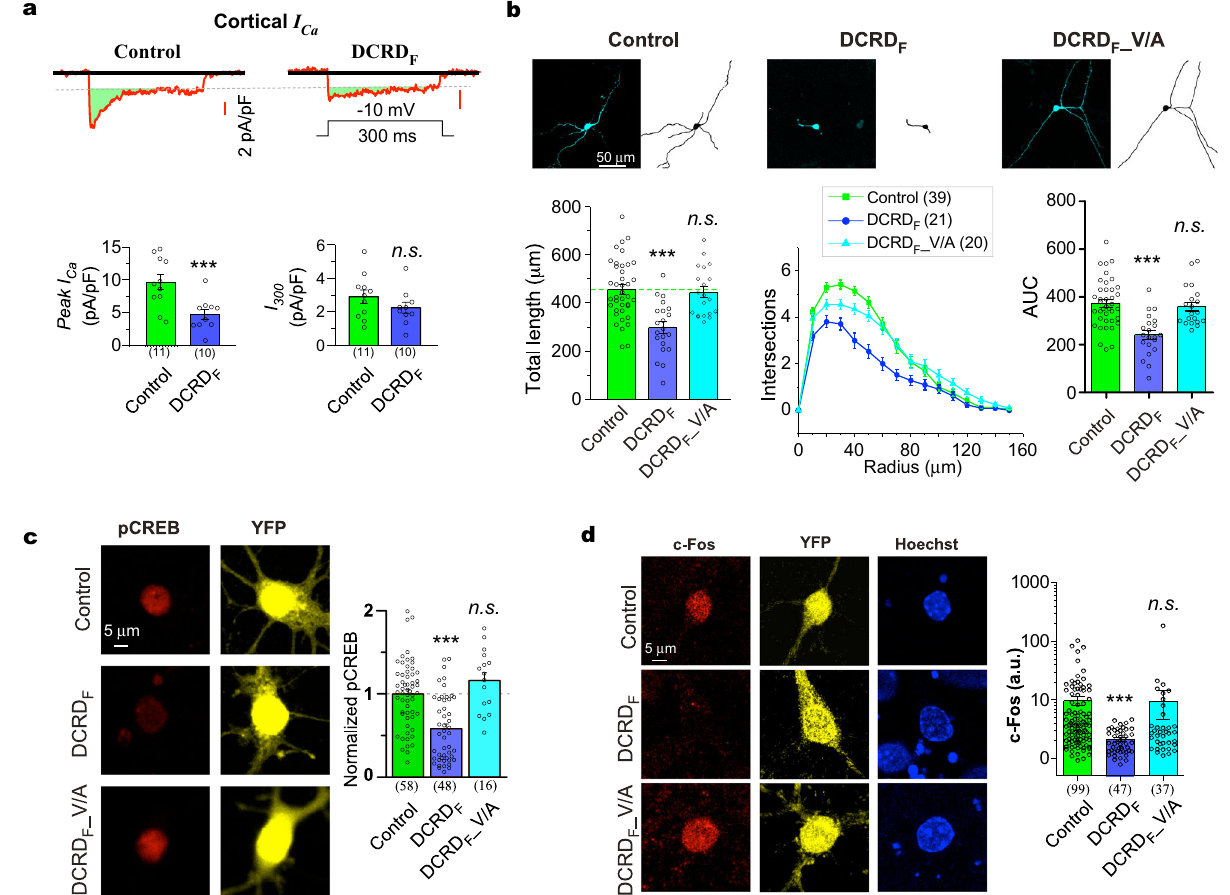
Fig. 1 DCRD F effects on Ca V 1.3 gating and neuritogenesis signaling in cortical neurons. a Inhibition of endogenous Ca V 1.3 currents by DCRD F peptides. Cultured neurons were treated with the cocktail recipe to isolate Ca V 1.3 Ca 2 + current (details in Supplementary Fig. 2). Exemplary Ca 2 + current (upper, scale bar in red) was elicited by the standard protocol of voltage step (300 ms; -10 mV). Potential inhibitory effects on channel functions were evaluated by the indices of peak and steady-state current amplitudes (pA/pF, bottom). b Effects on neuronal morphology. Based on the confocal fl uorescent images of peptide-expressing cortical neurons (upper row), neurite tracing for each neuron was performed (middle row), total neurite length and Sholl analyses summary (bottom row) were compared among the three groups: YFP, YFP-DCRD F and YFP-DCRD F _V/A. Sholl analyses are routinely accompanied by the quantitative index of AUC (area under the curve, lower right). c Effects of DCRD F peptides on pCREB signals. Cortical neurons were transfected with YFP, YFP-DCRD F or YFP-DCRD F _V/A (loss-of-function mutant), respectively. The pCREB signals were evaluated by immuno fl uorescence. Red and yellow fl uorescence in confocal images represent pCREB signals and overexpressed YFP, respectively. pCREB signals were normalized over the YFP control group. d Effects on c-Fos signals. Cortical neurons expressing YFP, YFP-DCRD F or YFP-DCRD F _V/A were stained with c-Fos antibody (in red). Fluorescent intensities of c-Fos signals in the nuclei were summarized. Student ’ s t -test ( a ), one-way ANOVA followed by Bonferroni for post hoc tests ( b, c ) and Kruskal-Wallis and Dunn ’ s non-parametric test ( d , non-normal distribution, checked by D ’ Agostino & Pearson omnibus normality test) were used (*** p < 0.001; n.s ., not signi fi cant, p > 0.05). Values are represented as mean ± SEM. COMMUNICATIONS BIOLOGY| (2022) 5:484